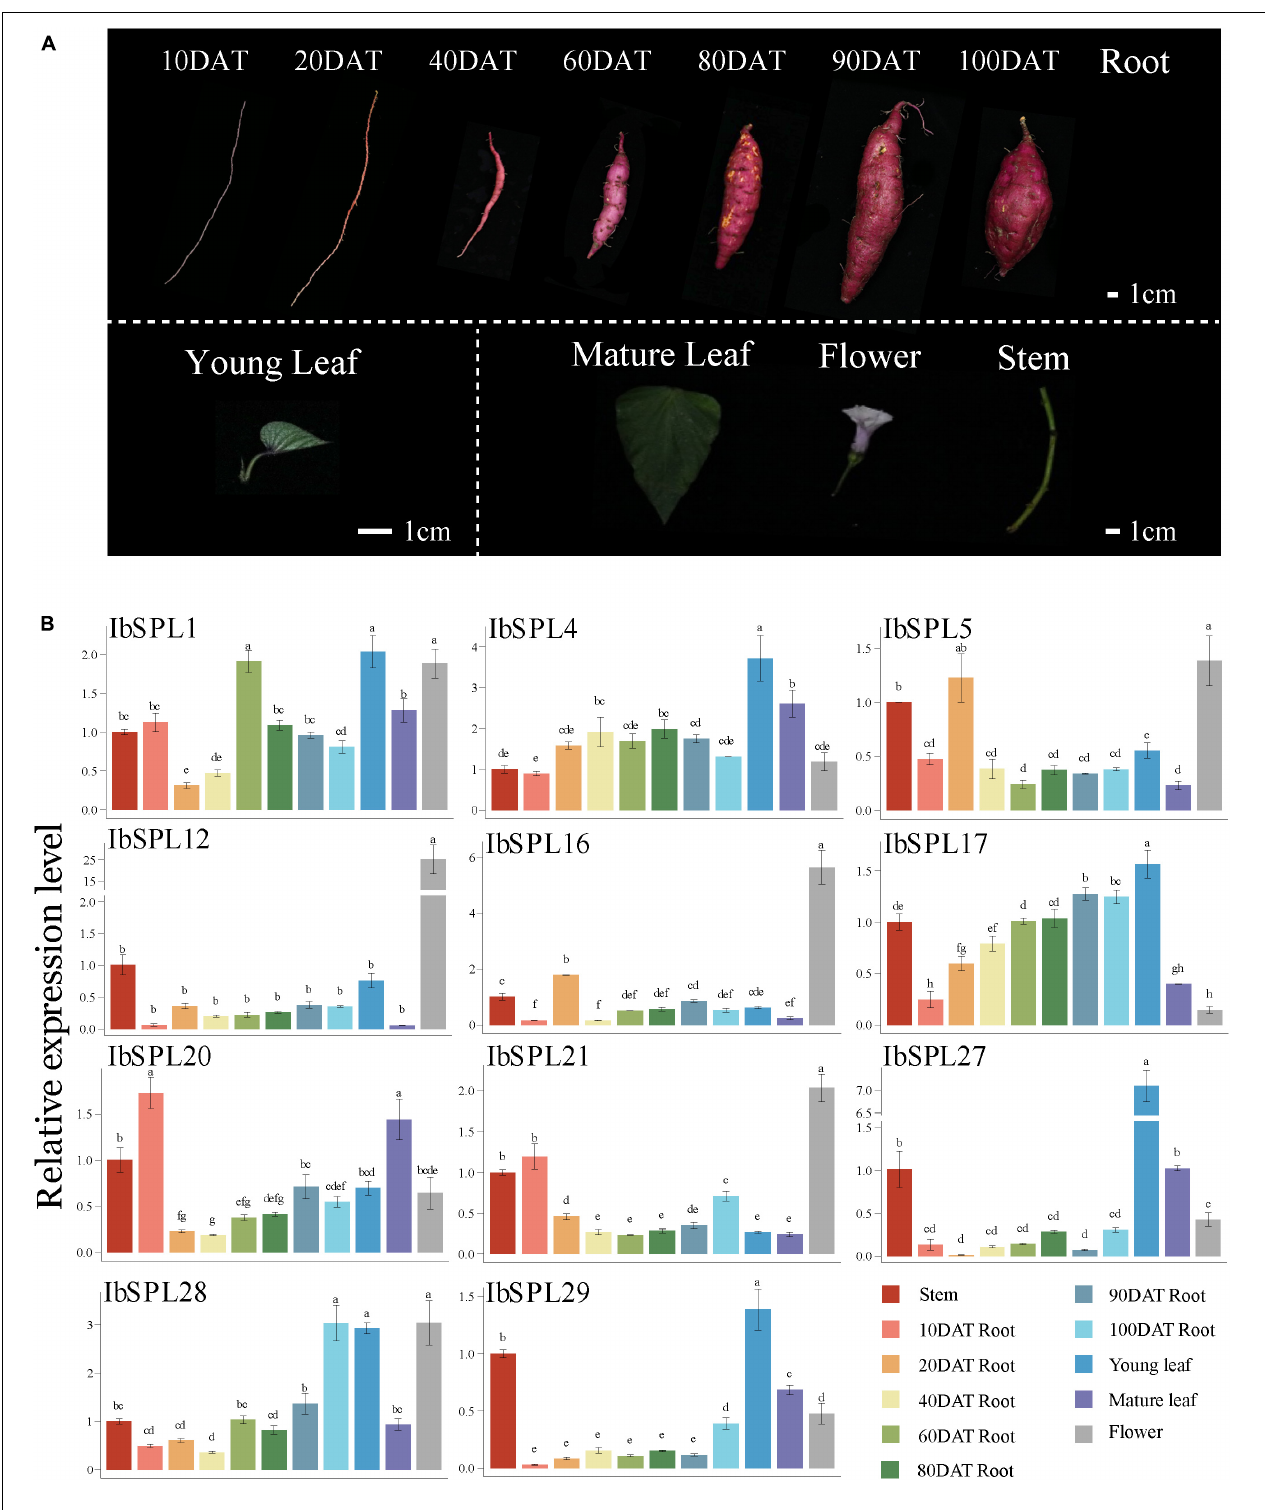
FIGURE 6 | Expression profiles of 11 IbSPL genes in different tissues and at different developmental stages using qRT-PCR. (A) Different tissues from cultivar Xuyu34 are shown, including stem, leaf, flower, and root. Black bar is scale of 1 cm. (B) Expression patterns of 11 IbSPL genes determined using qRT-PCR. The x -axis indicates different tissues. The y -axis represents the relative expression calculated using the 2 − (cid:49)(cid:49) CT method. The error bars indicate the standard deviations of the three biological replicates. Different letters indicate statistically significant differences at p < 0.05.